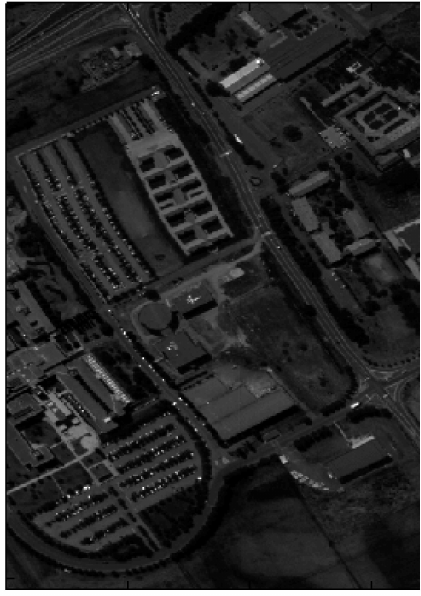
Figure 3. Sample band of the Pavia University dataset.